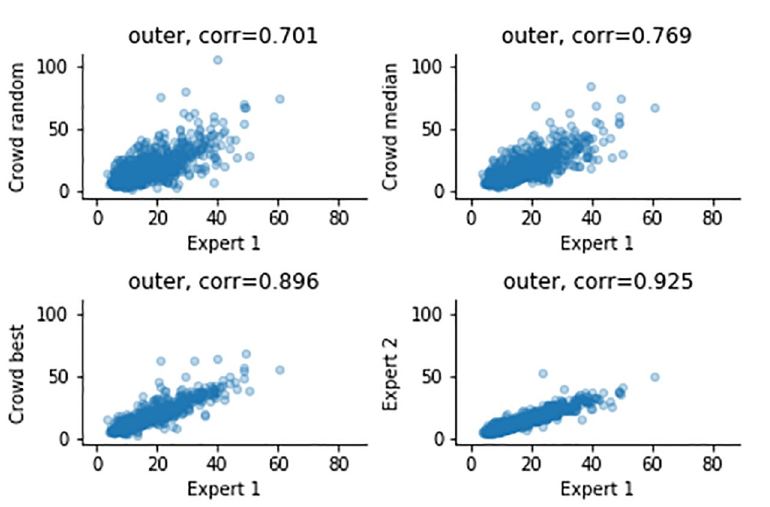
Fig 6. Measurements of the outer airway, comparing expert 1 (x-axis) and to three combining methods and expert 2 (y-axis).